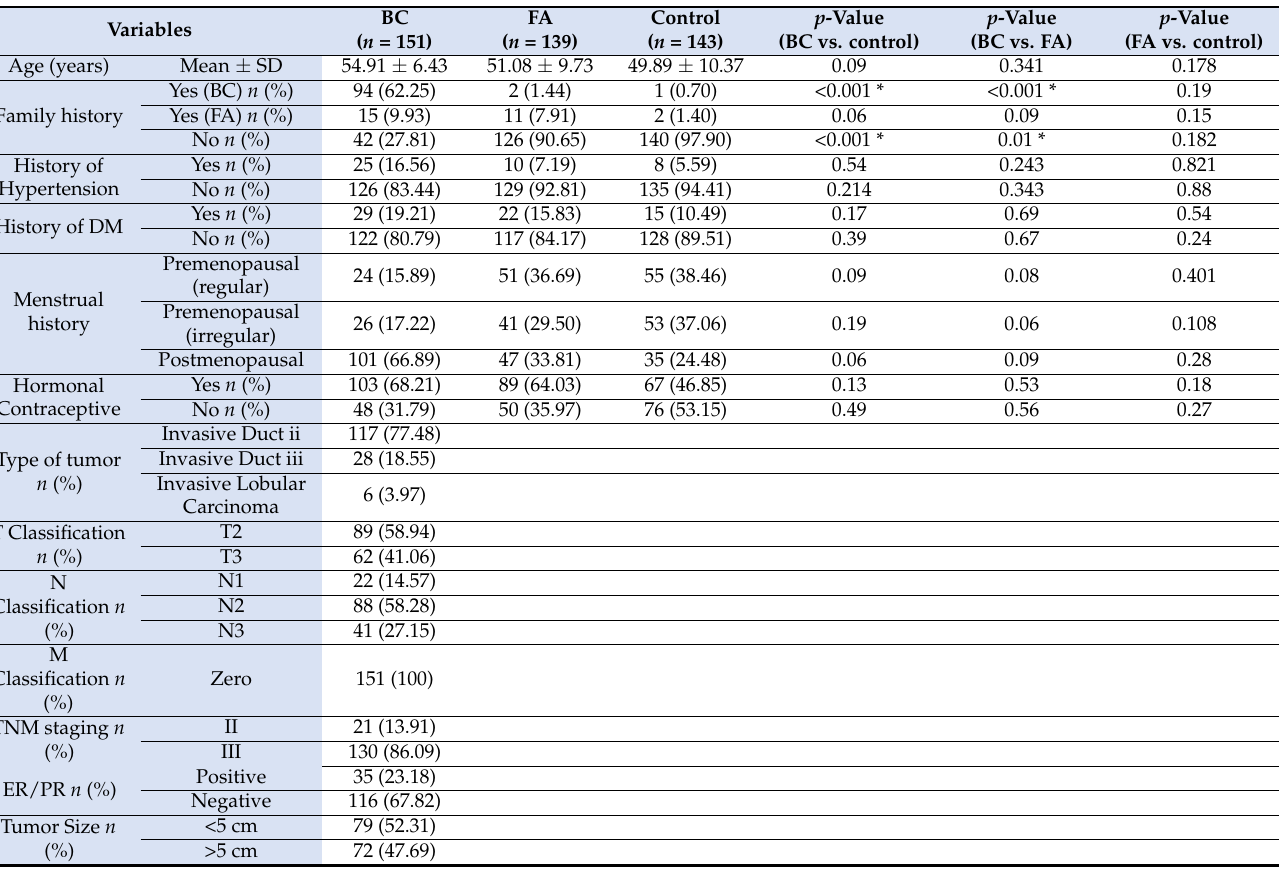
Table 1. Characteristics of the